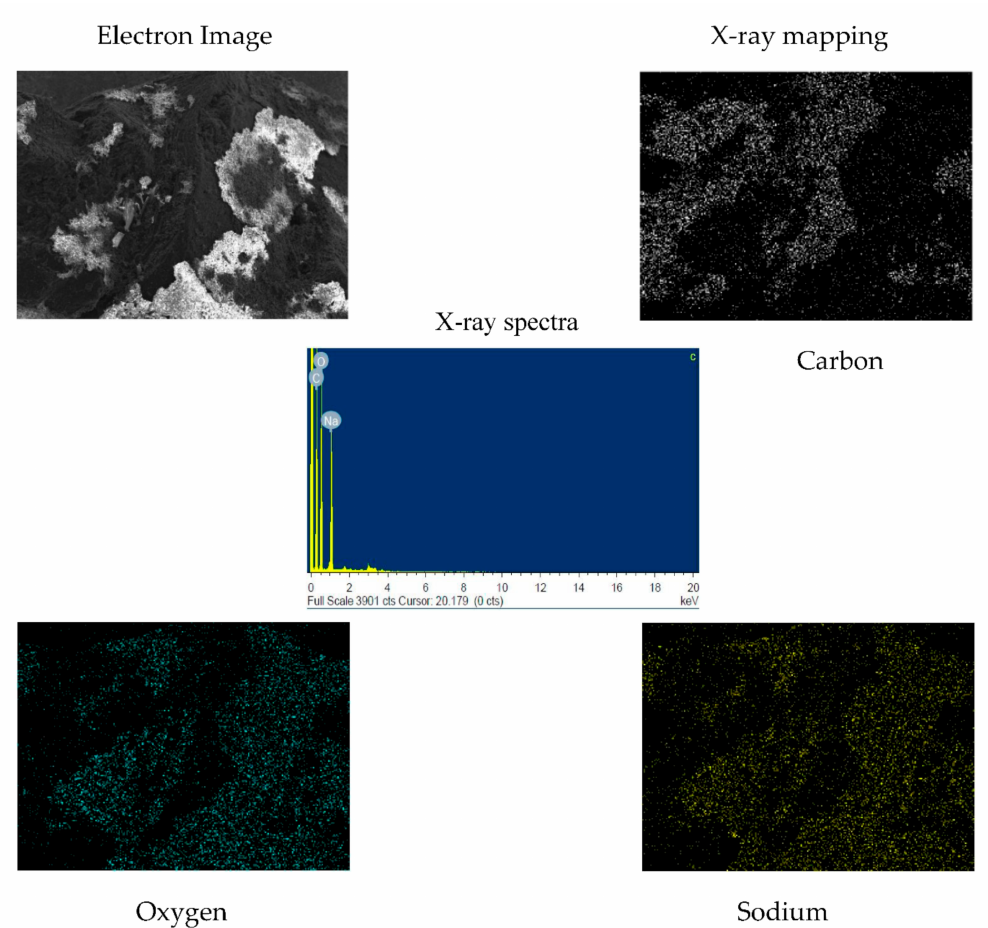
Figure 3. Results of SEM-EDX analysis of NaOH impregnated activated carbons (AC2-3